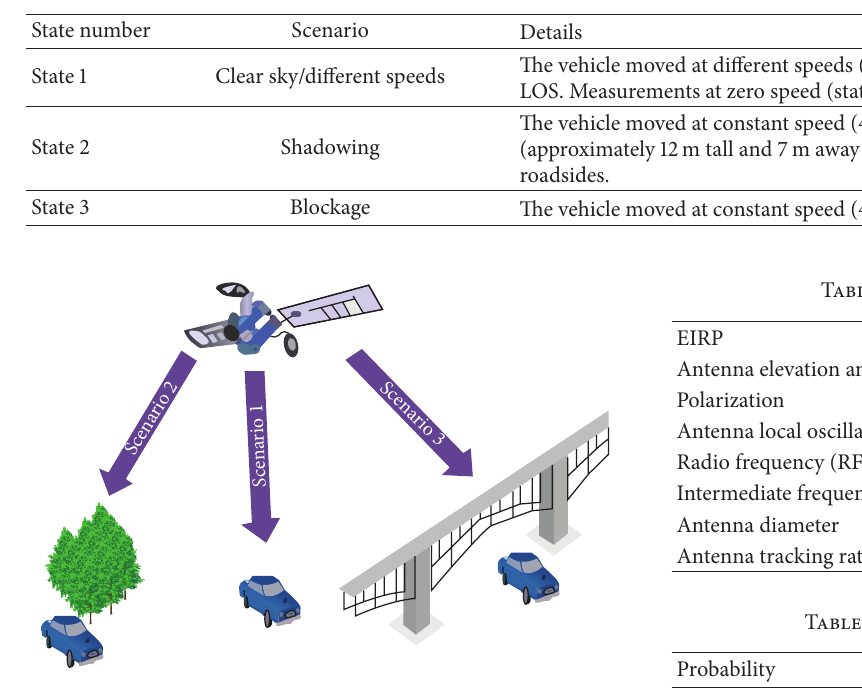
Figure 1: LMS link scenarios.